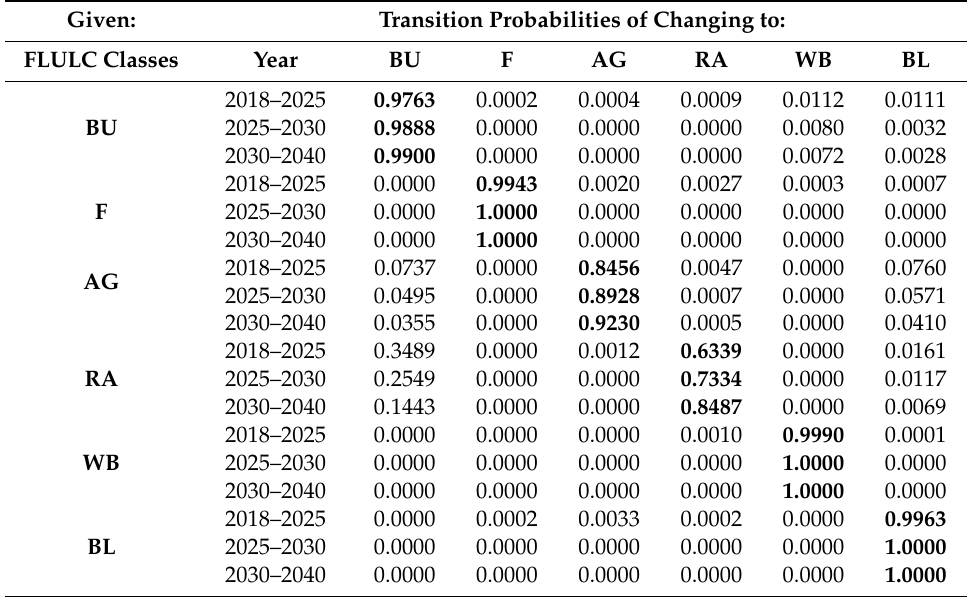
Table 8. Markov chain TPM of FLULC classes for the period 2018–2040 by percentage. Given: Transition Probabilities of Changing